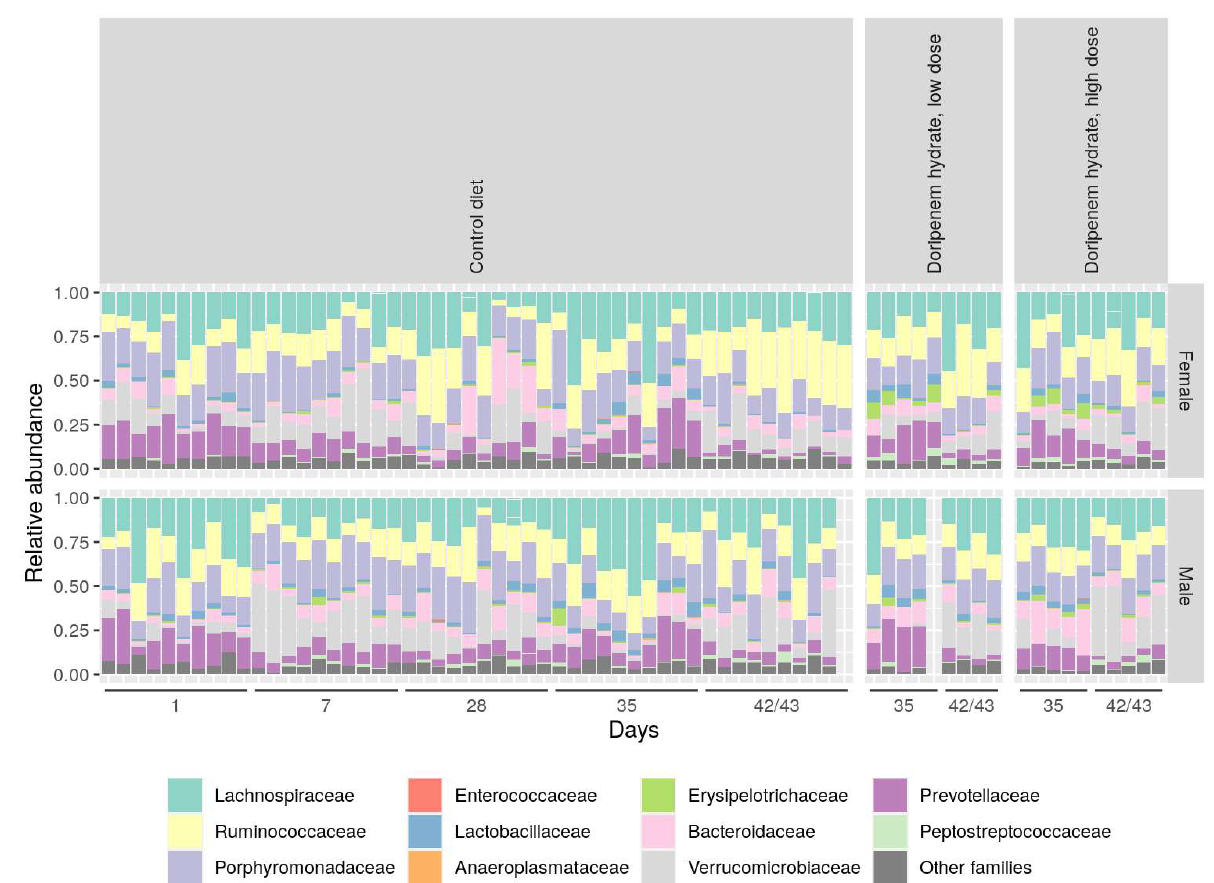
Figure 6. Stacked bar diagram showing relative abundances of bacterial families that were detected in the controls and doripenem-recovery groups. An indication of the recovery of abundant bacterial families one and two weeks post-doripenem treatment was observed and resulted in abundances comparable to the controls.